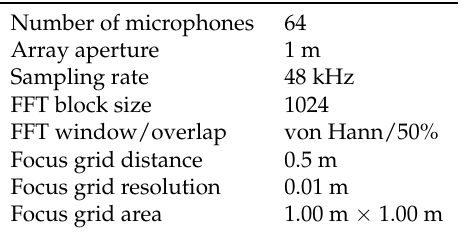
Figure 2. Experimental setup of the benchmark B11b ( a ) and the extended benchmark with a spiral microphone array ( b ). Blue dots mark the microphone positions and red dots mark the rotating source positions. The black circles show the trajectory of the rotating sources. Table 2. Simulation data processing